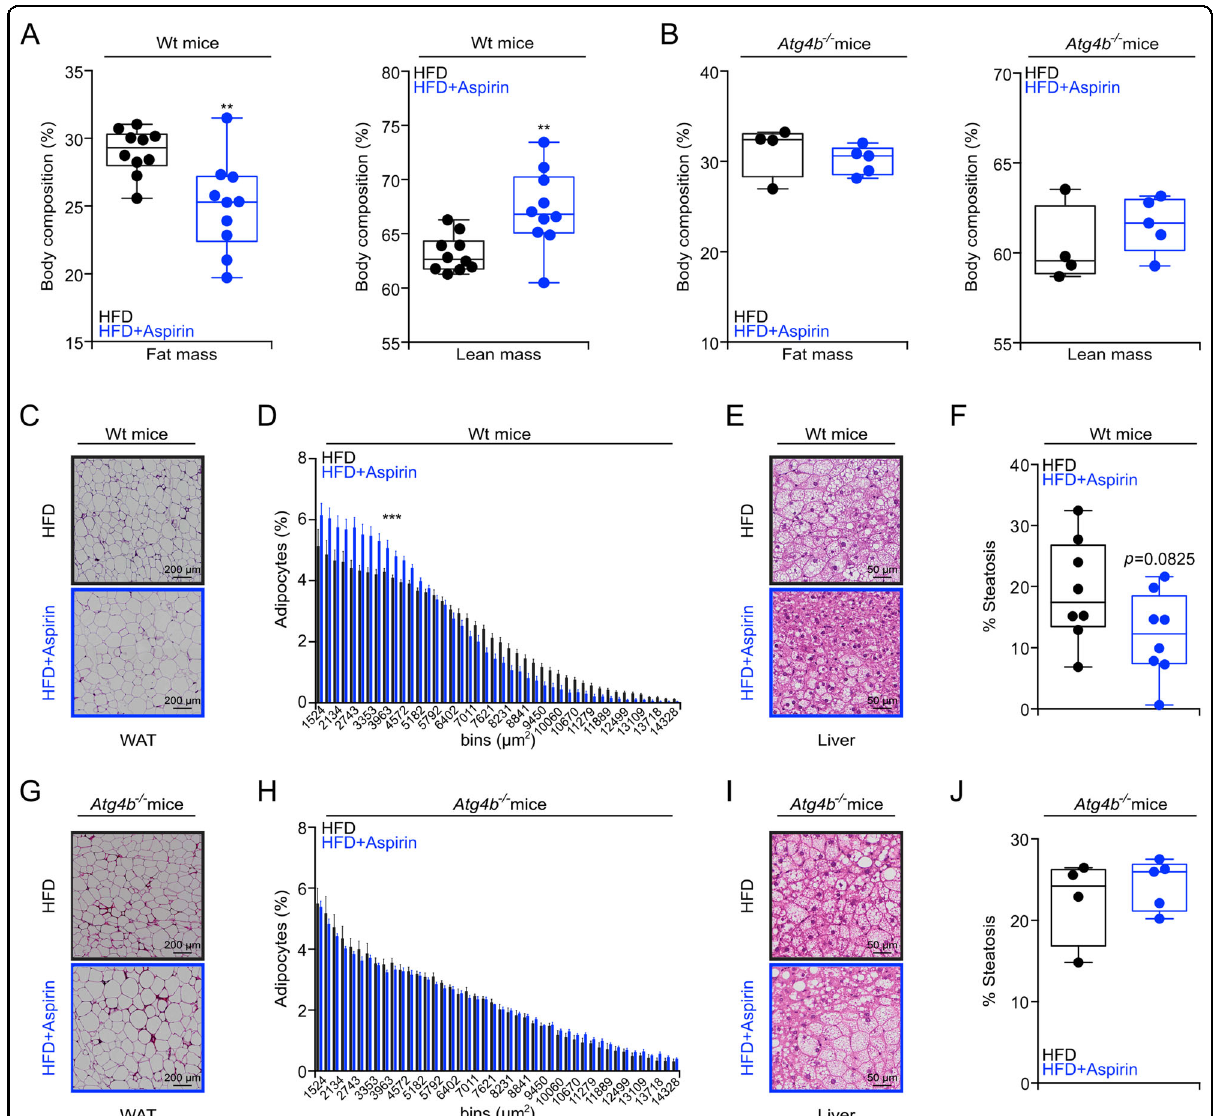
Fig. 5 Aspirin improves metabolic outcome in obesogenic conditions in autophagy-dependent manner. a , b Respectively, WT and Atg4b − / −